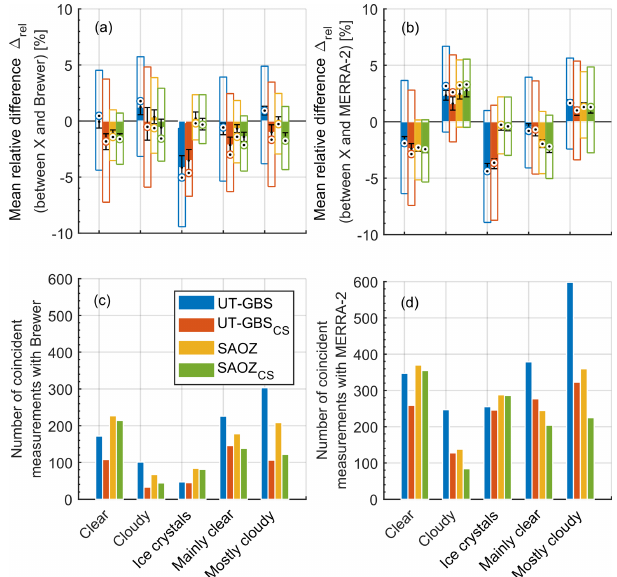
Figure 5. The impact of sky conditions on total column ozone mea- surements at Eureka: (a) mean relative difference between UT-GBS (SAOZ) TCO and Brewer TCO, (b) mean relative difference be- tween UT-GBS (SAOZ) TCO and MERRA-2 TCO. (c) The num- ber of coincident measurements corresponding to (a) and (d) the number of coincident measurements corresponding to (b) . Differ- ent colours represent different datasets, as indicated in the legend. In (a) and (b) , the hollow box represents the 75th to 25th percentile of the dataset, the target symbol (black dot with coloured circle around) represents the median value, the solid bar represents the mean value, and the error bars represent the standard error on the mean. In all panels, the x axis represents weather types reported at the Eureka Weather